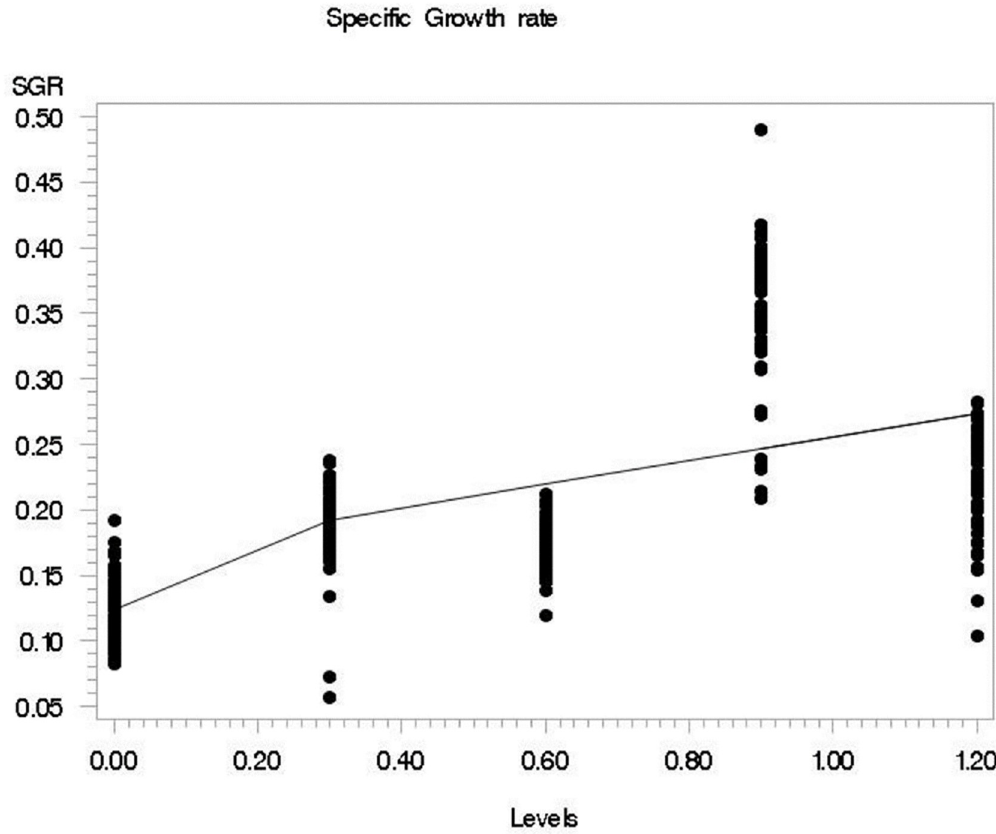
Fig 2. The fitted broken-line plot of SGR (specific growth rate) of Hypophthalmichthys molitrix fed on different levels of selenium methionine. Liner broken-line fitted model for selenium levels; Y = 0.1921–0.22 (100-X) × I, I = 1 (if X < 100) or I = 0 (if X > 100), P < . 002 , R 2 = 0.60, the breakpoint occurred at 0.27 ± 0.02.